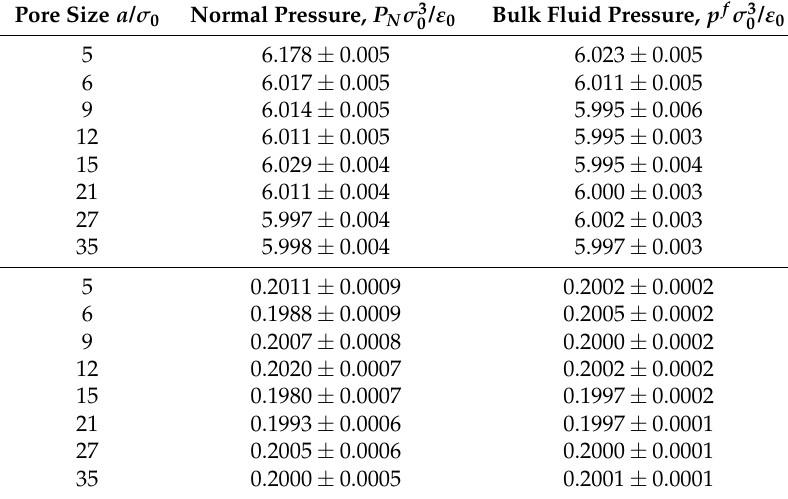
Table 1. The pressure tensor normal to the slit pore wall, P N , and the bulk pressure p f with varying pore sizes a . Two total pressures are studied for various pore